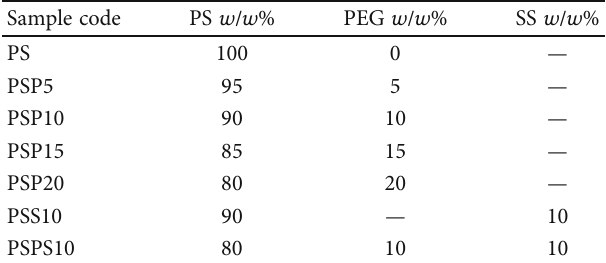
Table 1: Compositions of blends.